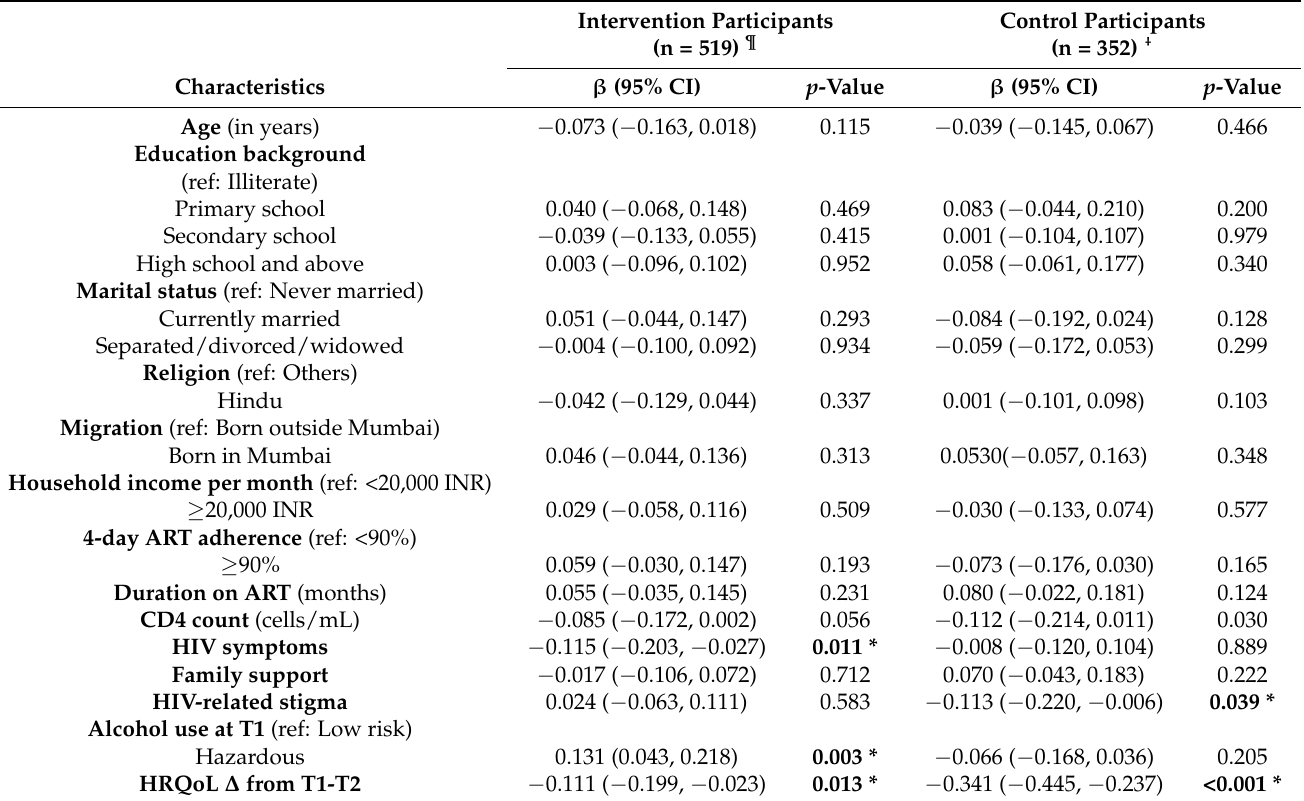
Table 3. Multiple linear regression of factors associated with changes in depression symptoms